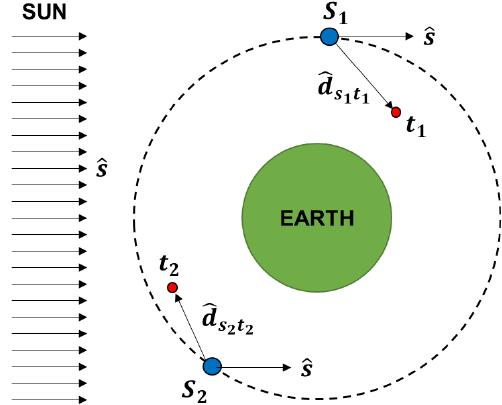
Figure 18. Visibility